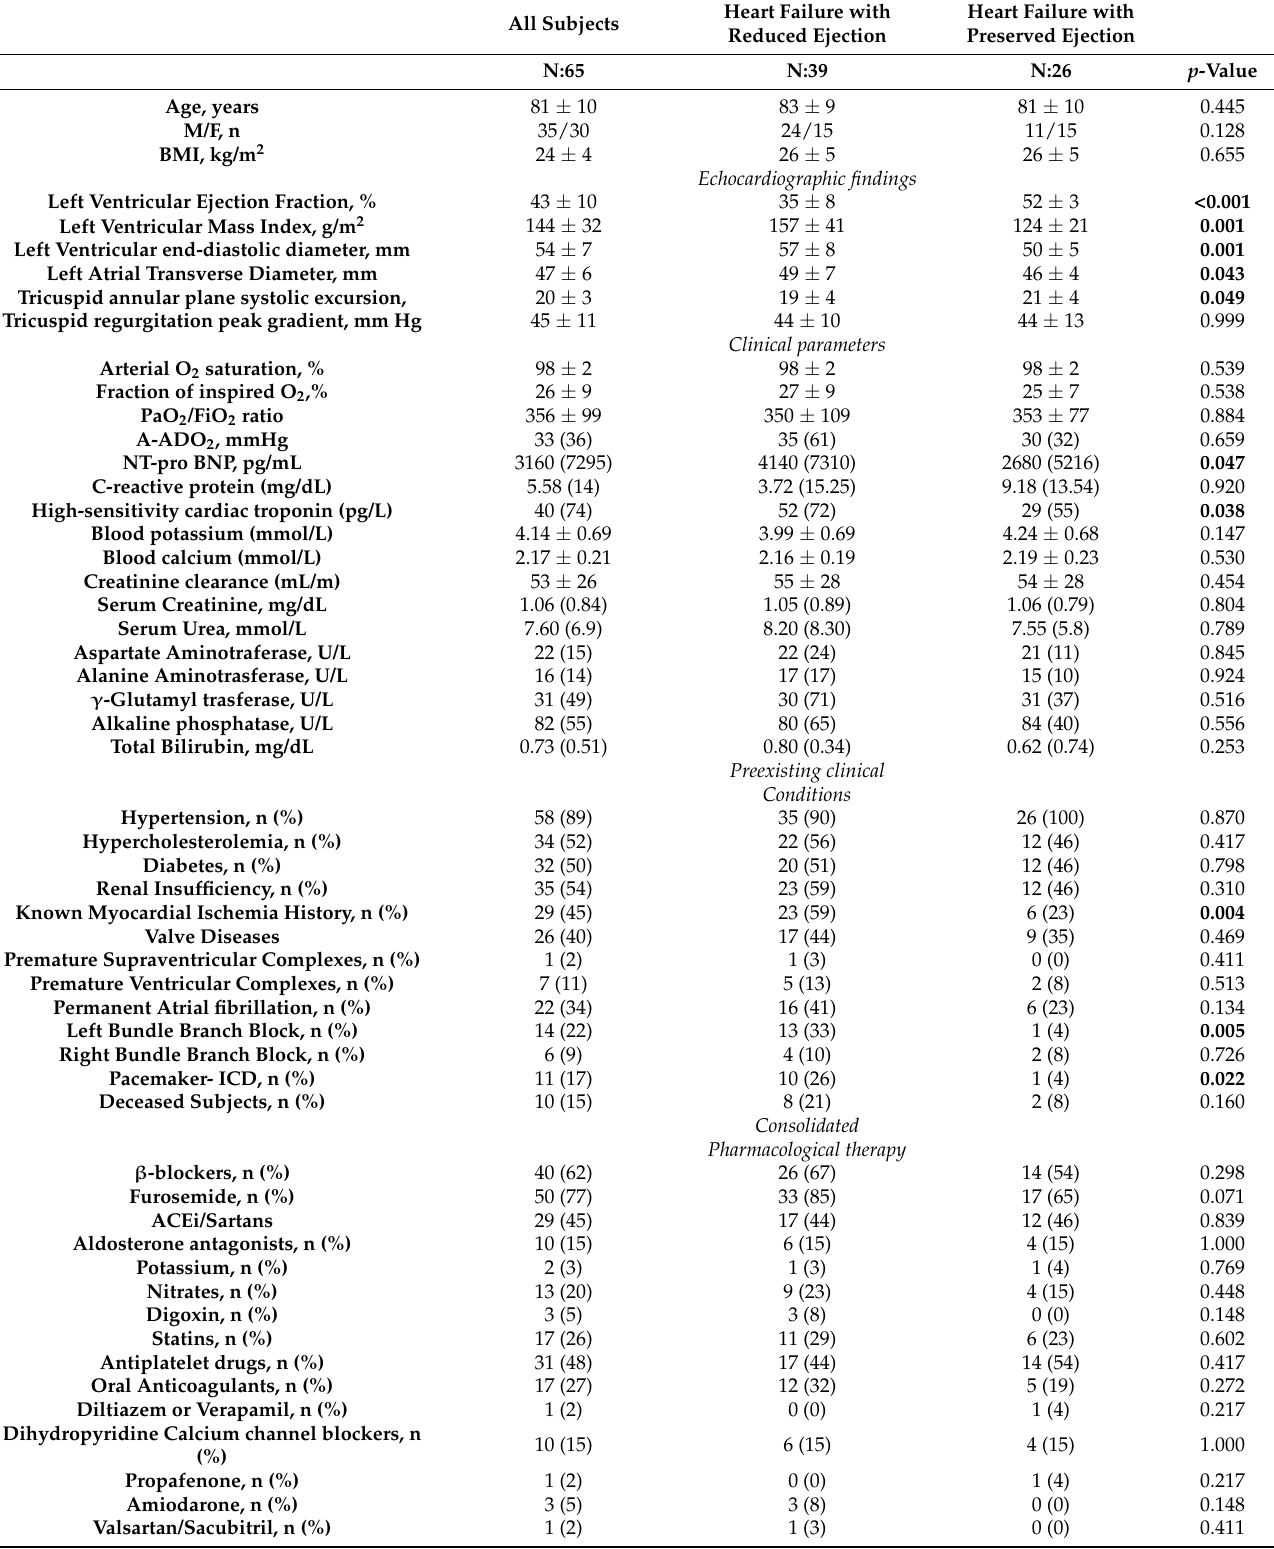
Table 1. Characteristics of the study